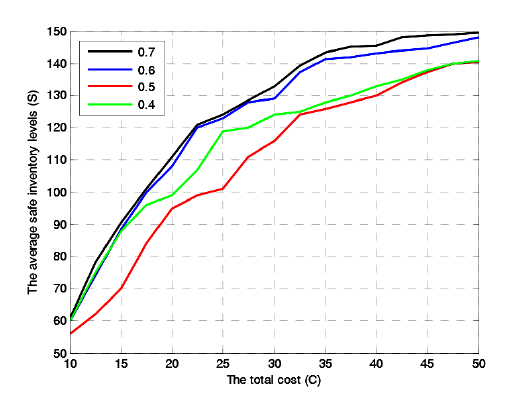
Figure 11. The sensitivity of